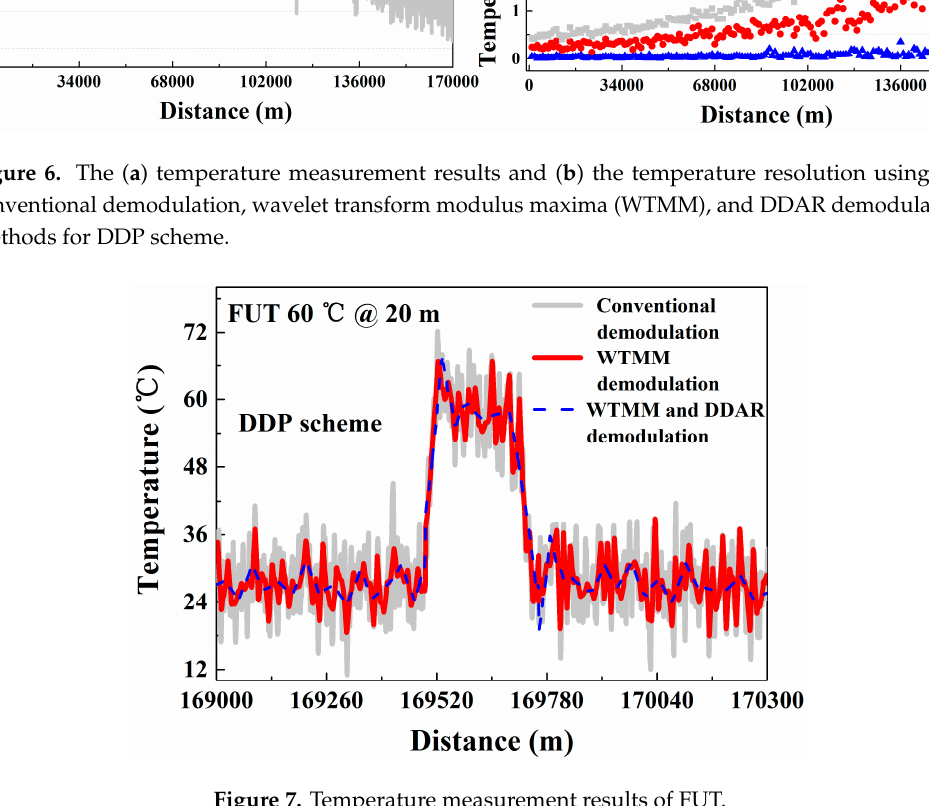
Figure 6. The ( a ) temperature measurement results and ( b ) the temperature resolution using the conventional demodulation, wavelet transform modulus maxima (WTMM), and DDAR demodulation methods for DDP scheme.